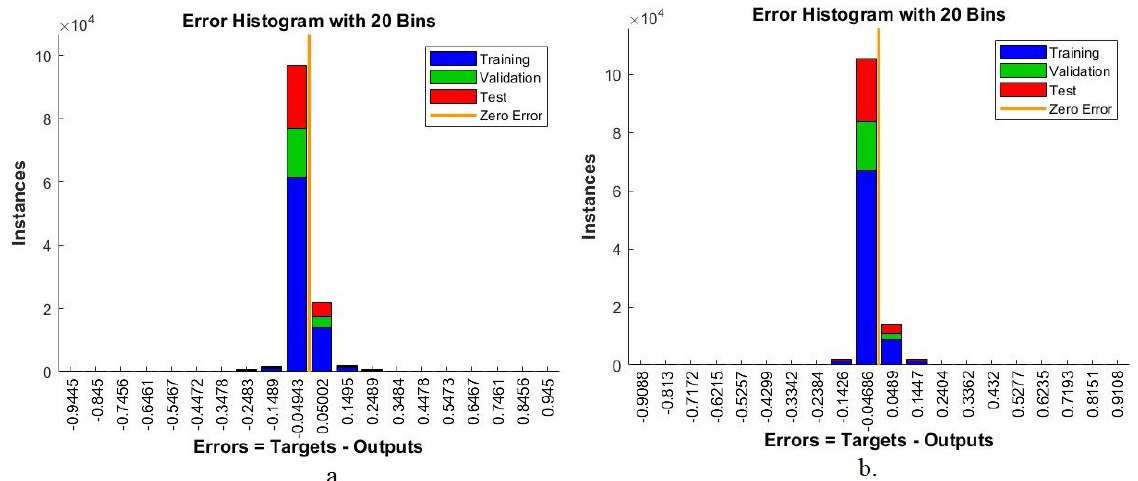
Figure 11. Error histogram display for diagnosing abnormal cell images of the cervix by ANN based on the features of ( a ). VGG ‐ 16, FCH, GLCM and LBP ( b ). GoogLeNet, FCH, GLCM and LBP.